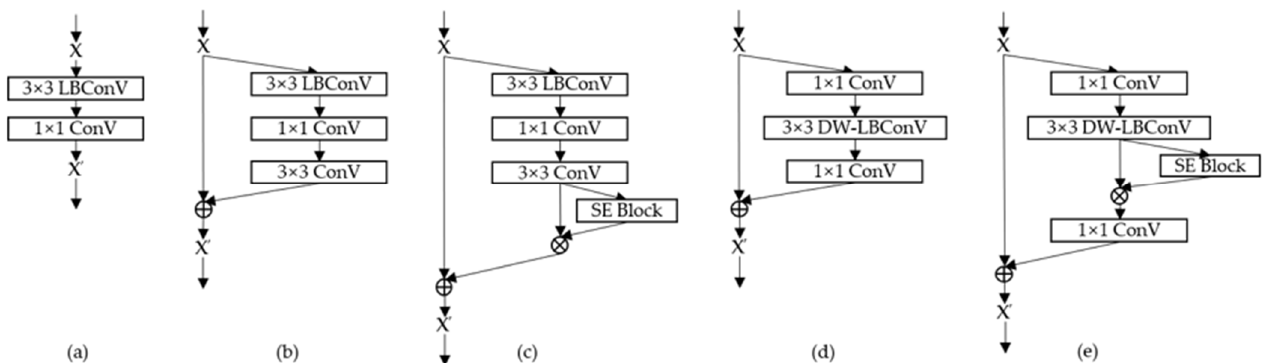
Figure 2. The difference between the standard LBC (local binary convolution) and the LBC blocks we proposed. ( a ) standard LBC layer; ( b ) standard LBC with residual module; ( c ) standard LBC with SE-residual module; ( d ) standard depthwise LBC with mobile inverse bottleneck module; ( e ) standard depthwise LBC with SE-mobile inverse bottleneck module.